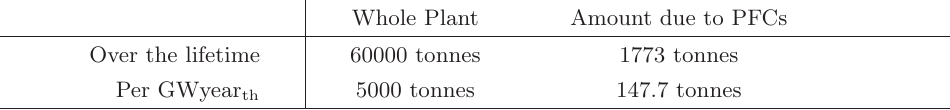
Table II. – Waste produced in DEMO over the lifetime and per GWyear